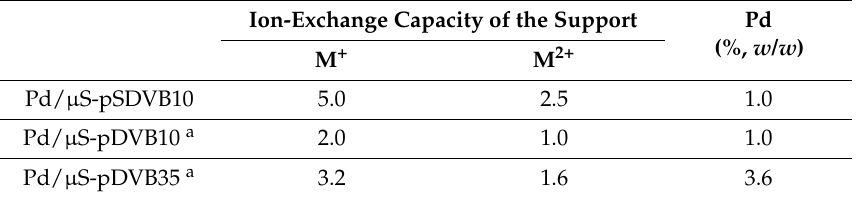
Table 1. Selected analytical data on the resin-supported Pd catalysts employed in this work. Ion-Exchange Capacity of the